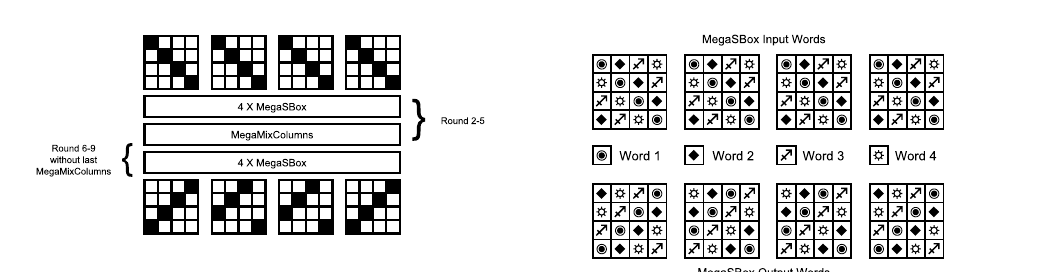
Figure 6: Word configuration for each MegaSBox